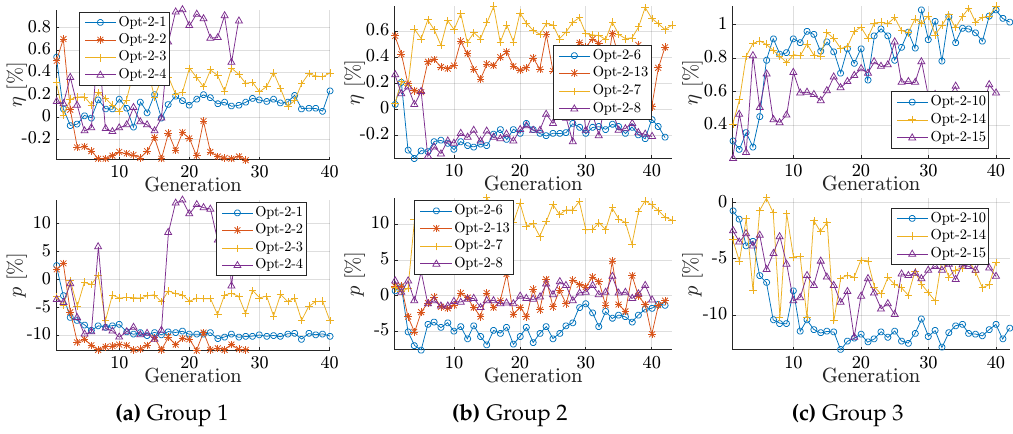
Figure A3. Development of objectives, given as median of relative improvements per generation.